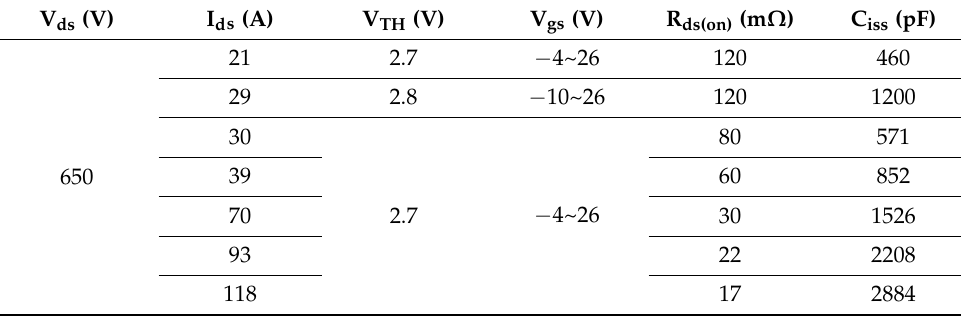
Table 8. Commercial 600~1200 V SiC MOSFETs by Rohm Semiconductor.